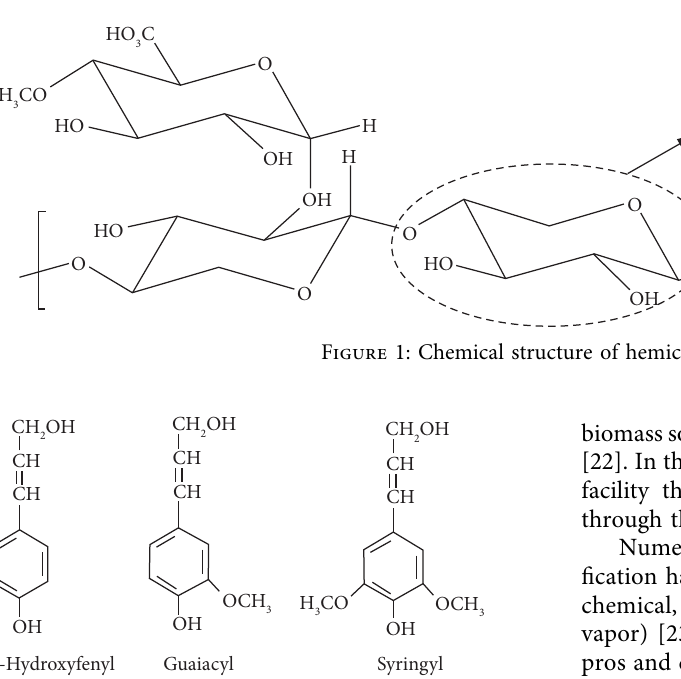
Figure 2: Structure of the main subunits of lignin precursors